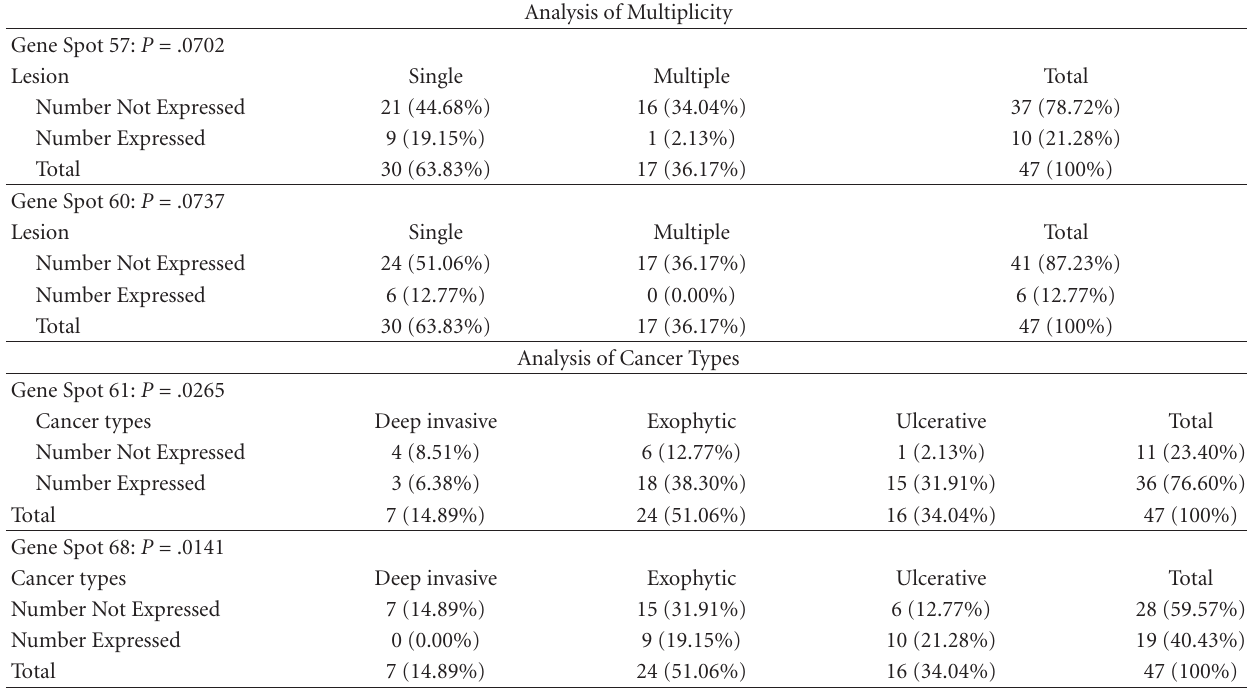
Table 4: Statistical association of viral gene expression patterns with cancer manifestations. Analysis of